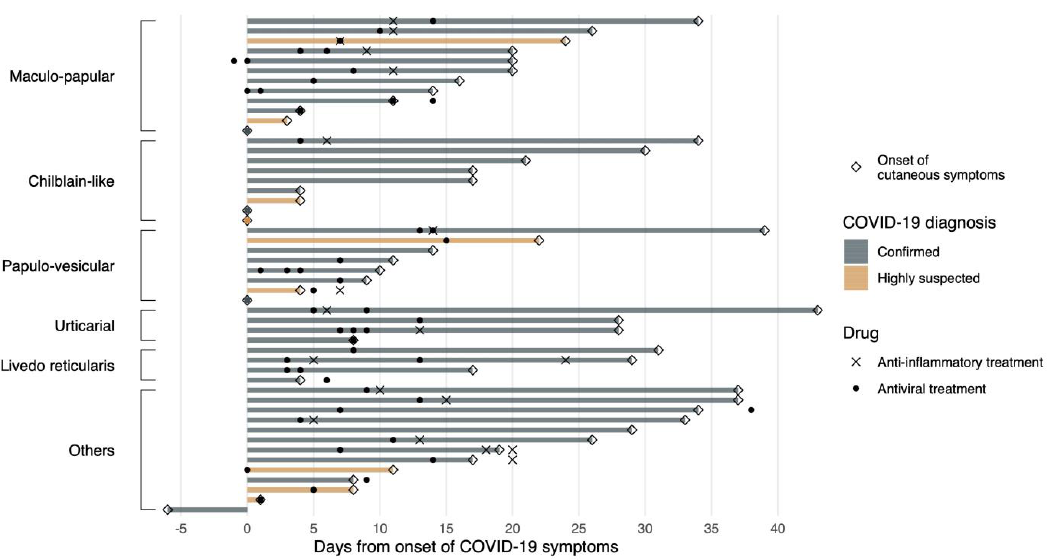
Figure 2. Swimmers plot showing the relationship between the onset of cutaneous manifestations with respect to other COVID-19 related symptoms. The figure also shows the initiation of treatment according to confirmed or highly suspected cases. When more than one treatment appears in a single patient, it indicates the initiation of a different type of drug (either antiviral or anti-inflammatory) along time.